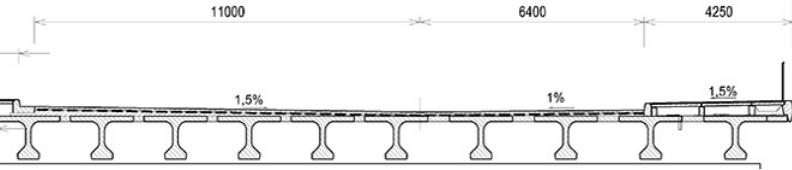
Figure 2. Cross-section of a bridge with pre-stressed beams